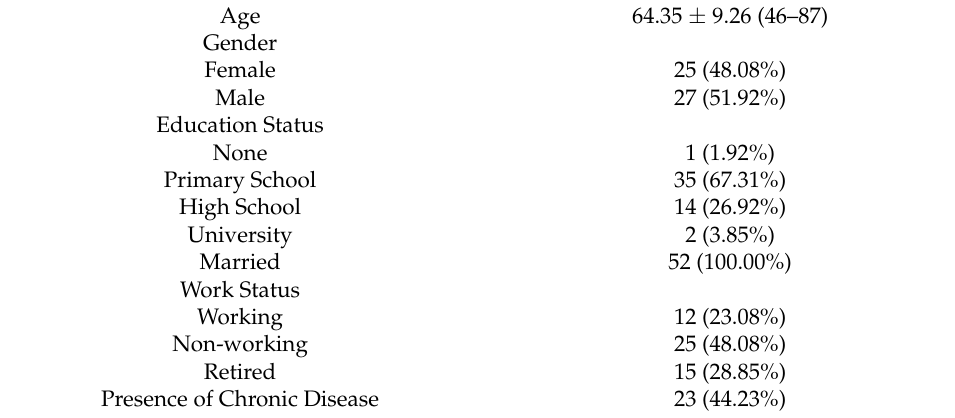
Table 1. Summary of patient characteristics.